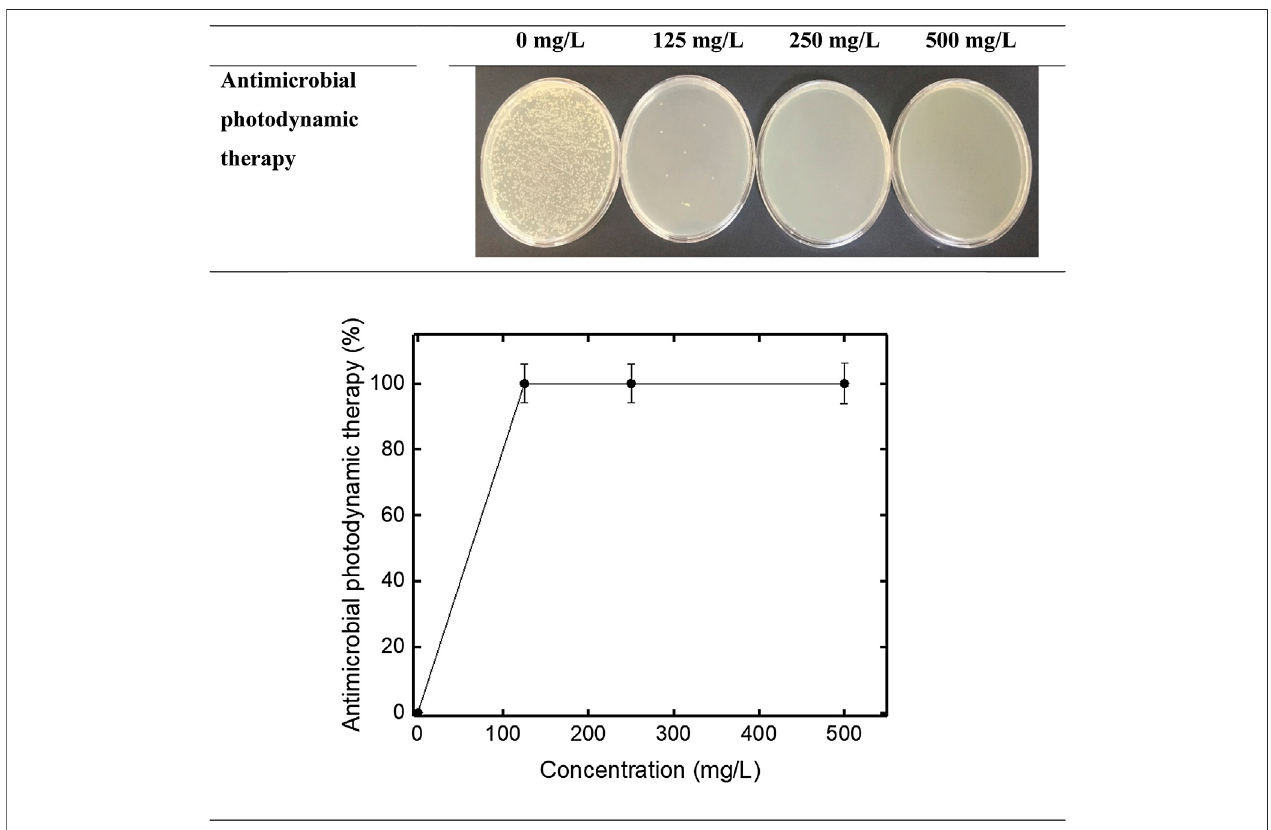
FIGURE 9 | Antimicrobial photodynamic